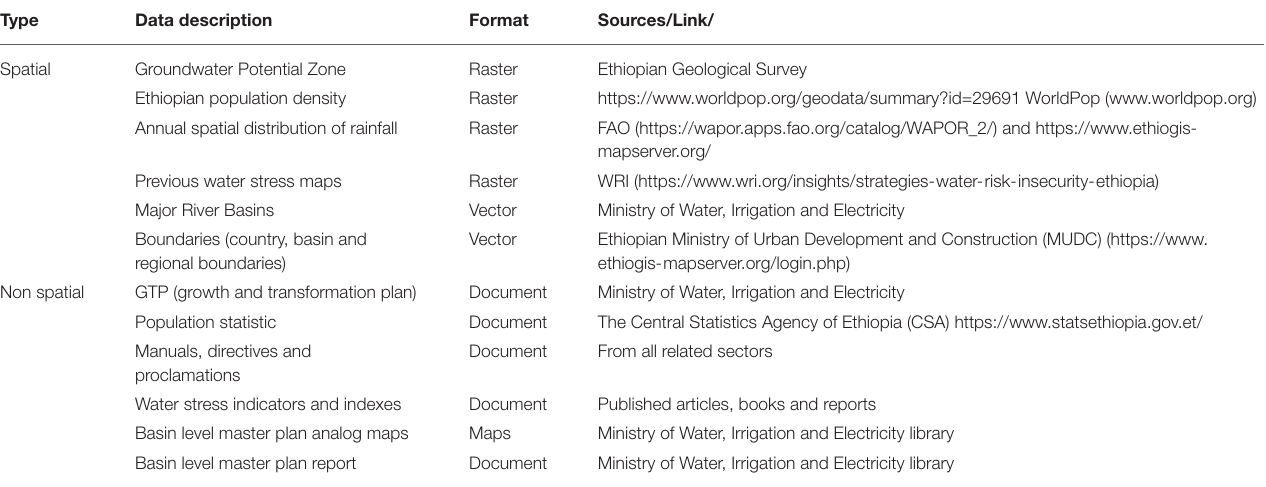
TABLE 4 | Spatial and non-spatial data